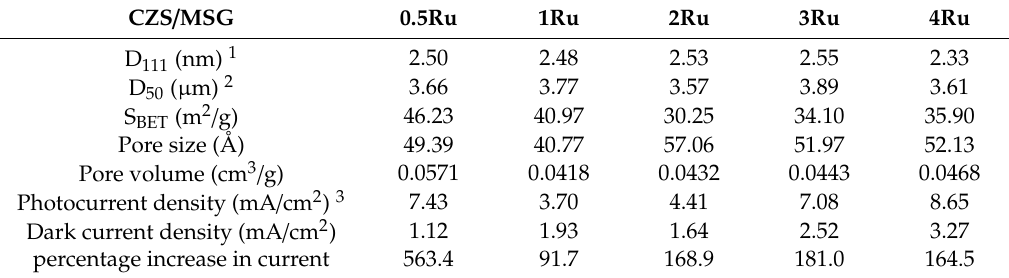
Table 1. Summary of average crystallite size D 111 , particle size distribution D 50 , BET, and photocurrent of as-synthesized CZS / MSG heterostructured photocatalysts with di ff erent amounts of ruthenium.